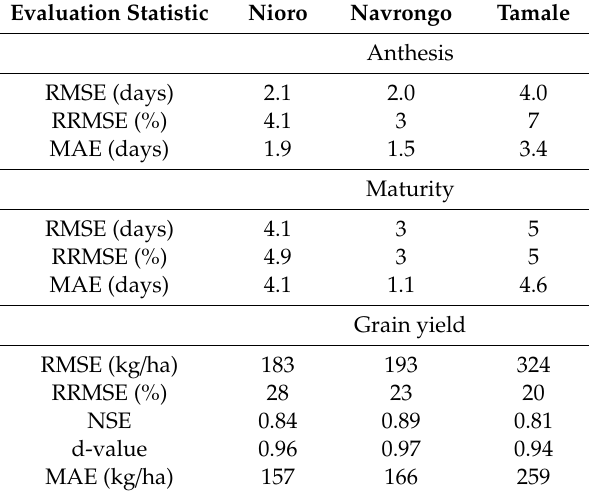
Table 6. Performance of the model in predicting maize anthesis, maturity and grain yields for Nioro, Navrongo and